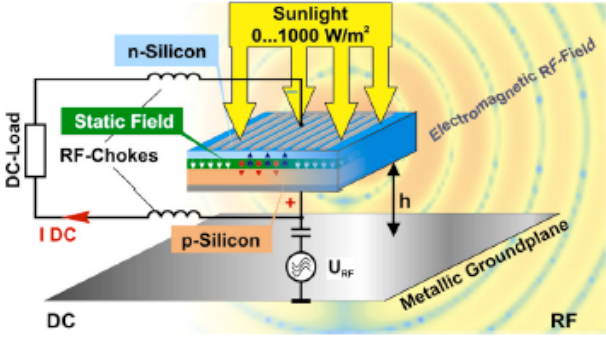
Figure 1. Basic principle of solar cell